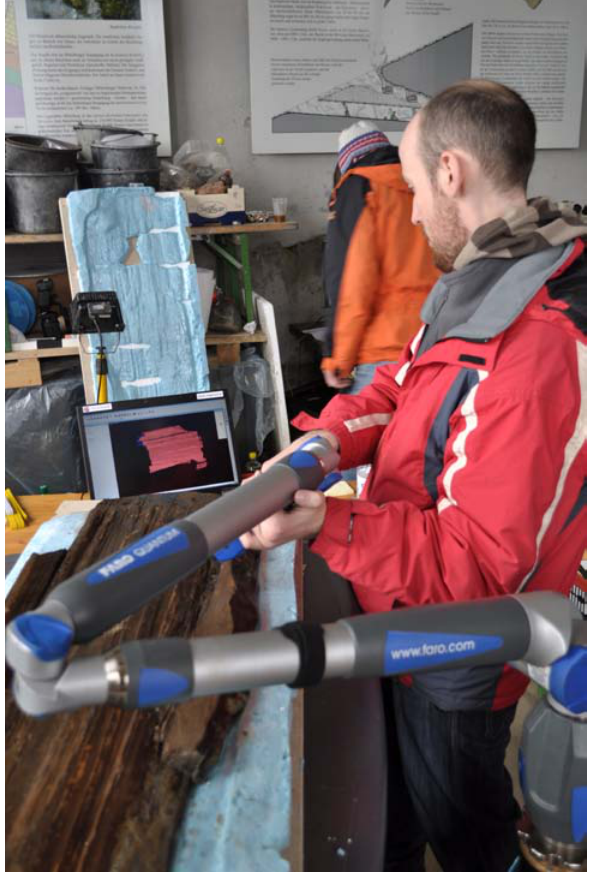
Figure 5. The documentation of the sluice box with the FARO® close range laser